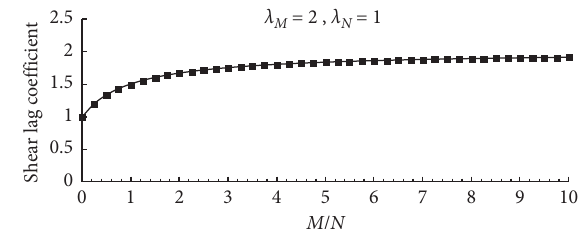
Figure 14: Relationship between shear lag coefficient and bending moment axial force